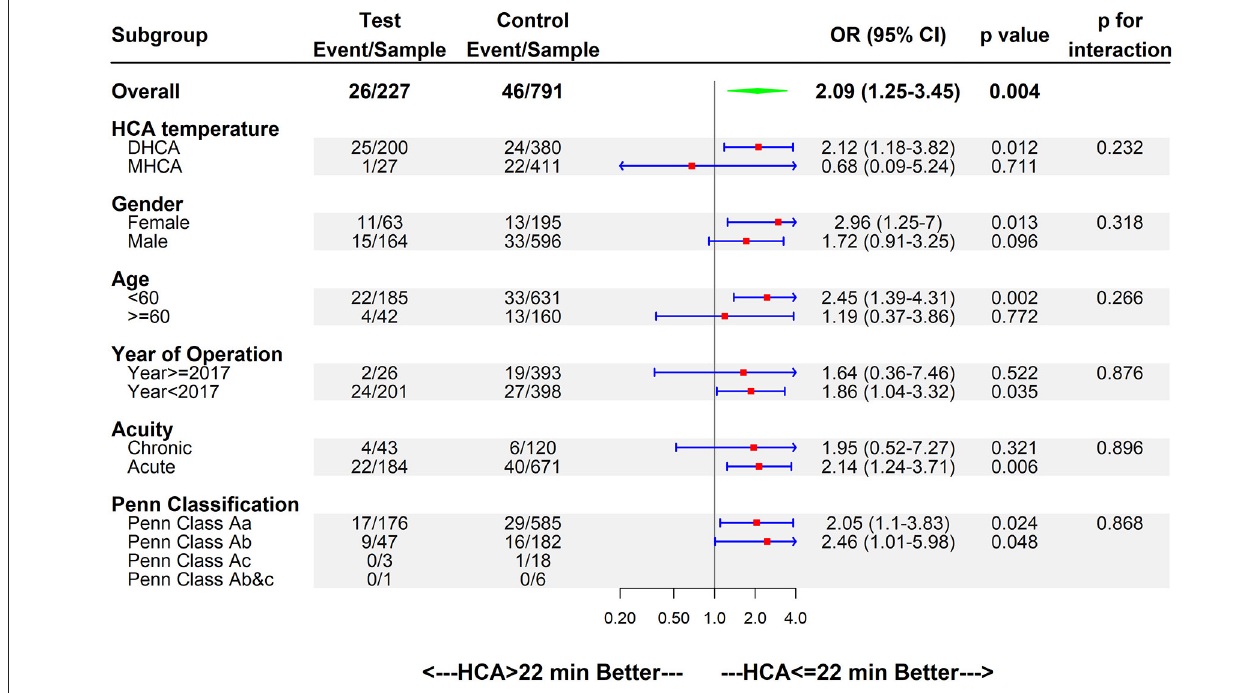
FIGURE 3 | Forest plot of HCA > 22min better vs. HCA ≤ 22min better regarding early mortality by subgroups. OR, odds ratio; CI, confidence